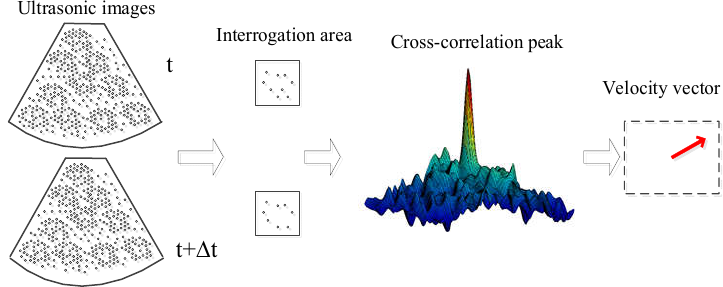
Figure 2. The principle of the flow velocity measurement method based on the ultrasound PIV tech- nique.